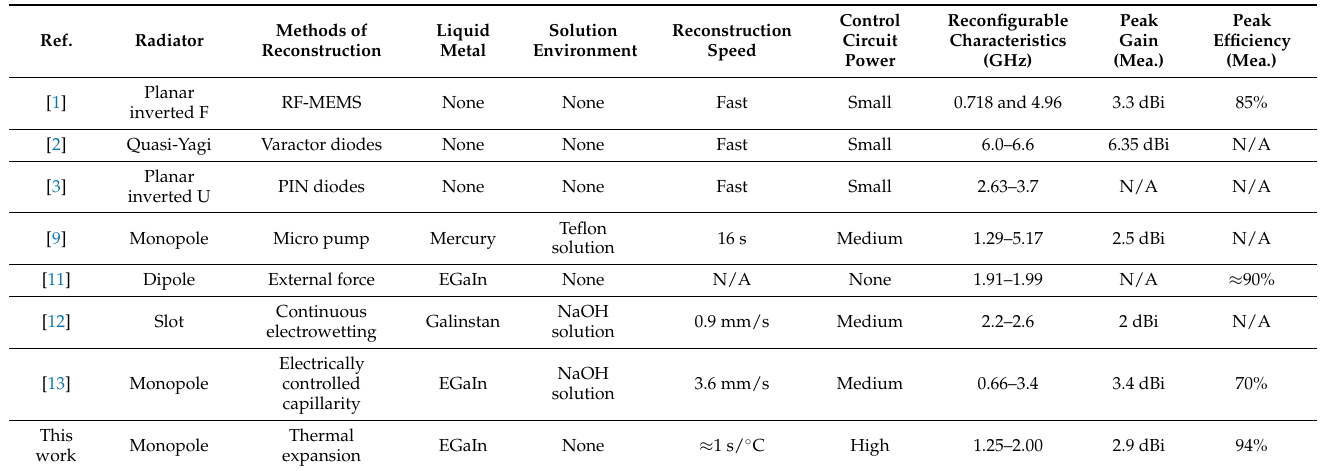
Table 3. Performance comparison between different